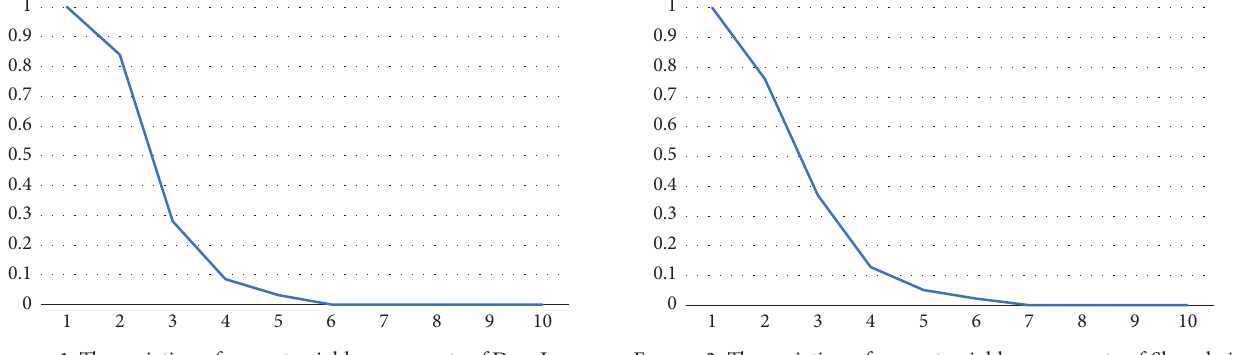
Figure 2: The variation of nearest neighbor error rate of Shanghai Composite Index with embedding dimension.